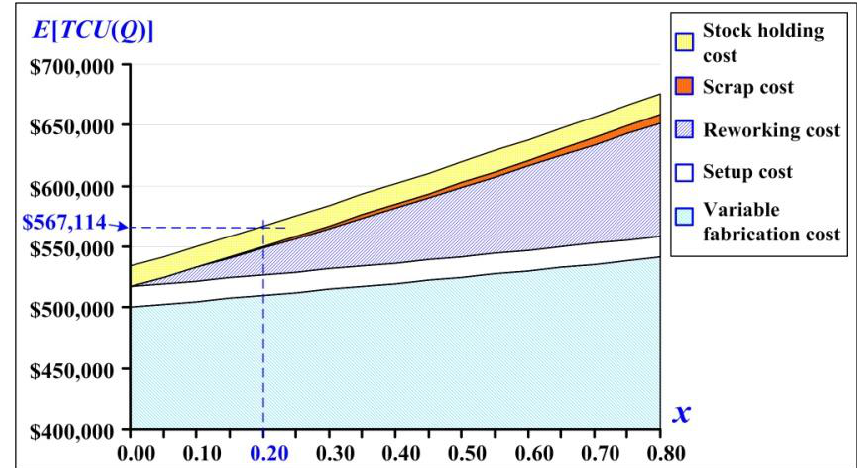
Figure 5. Variations of nonconforming rate x effects on different system’s cost